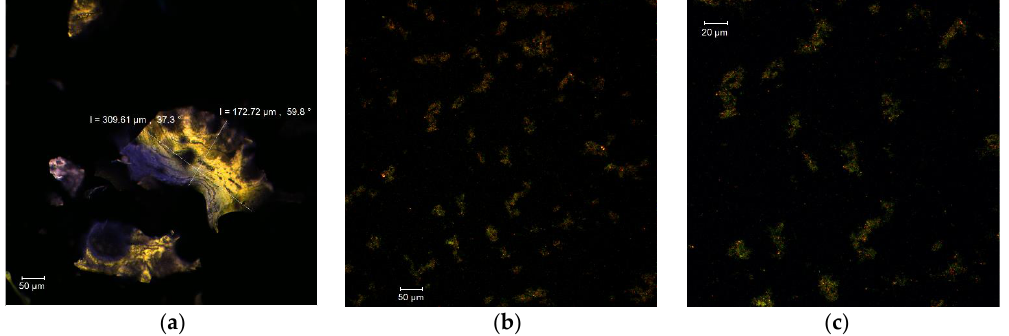
Figure 1. Confocal laser scanning microscopy images of MBC: native state MBC ( a ); fluorescently labelled MBC, magnification 0.6—707.3 µm × 707.3 µm, with pixel size of 0.60 µm ( b ); and fluorescently labelled MBC, magnification 1—424.4 µm × 424.4 µm with pixel size of 0.36 µm ( c ).